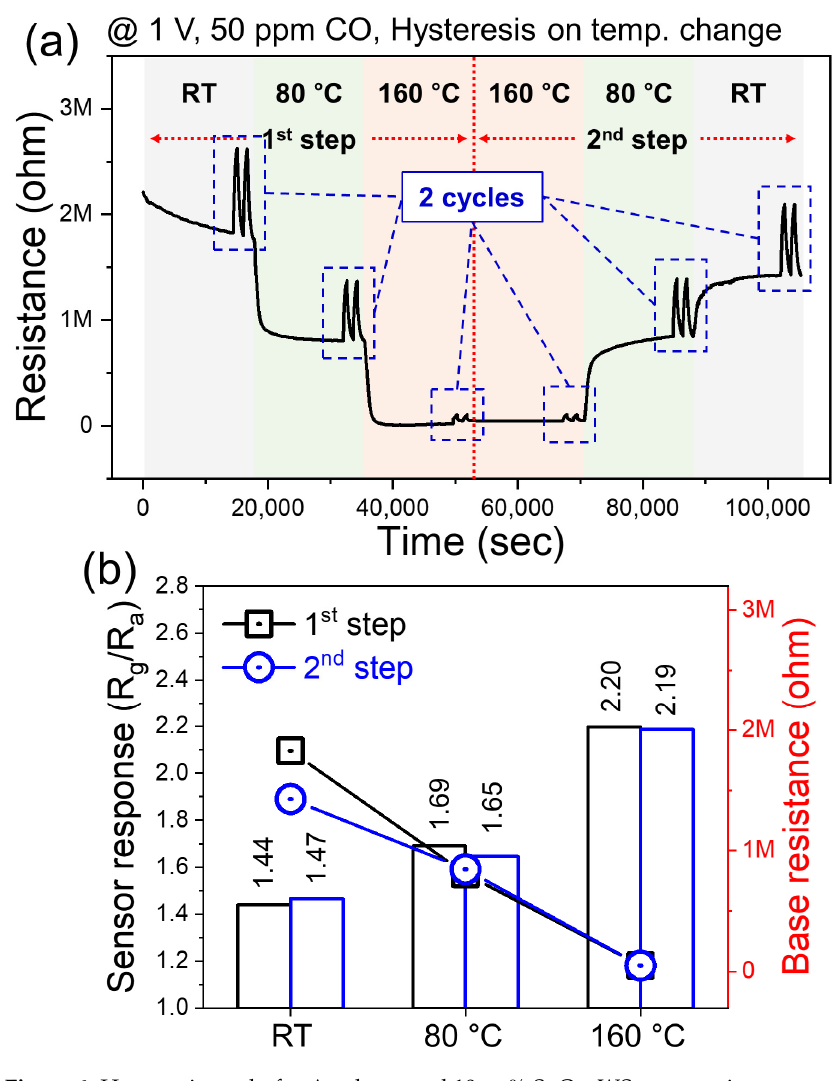
Figure 6. Hysteresis study for Au-decorated 10 wt% SnO 2 –WS 2 composite gas sensor ( a ) dynamic resistance plots under 1 V applied voltages during the increasing and decreasing of the temperature. ( b ) Comparison between the response of sensors at the same temperatures during increasing and decreasing of the temperature.